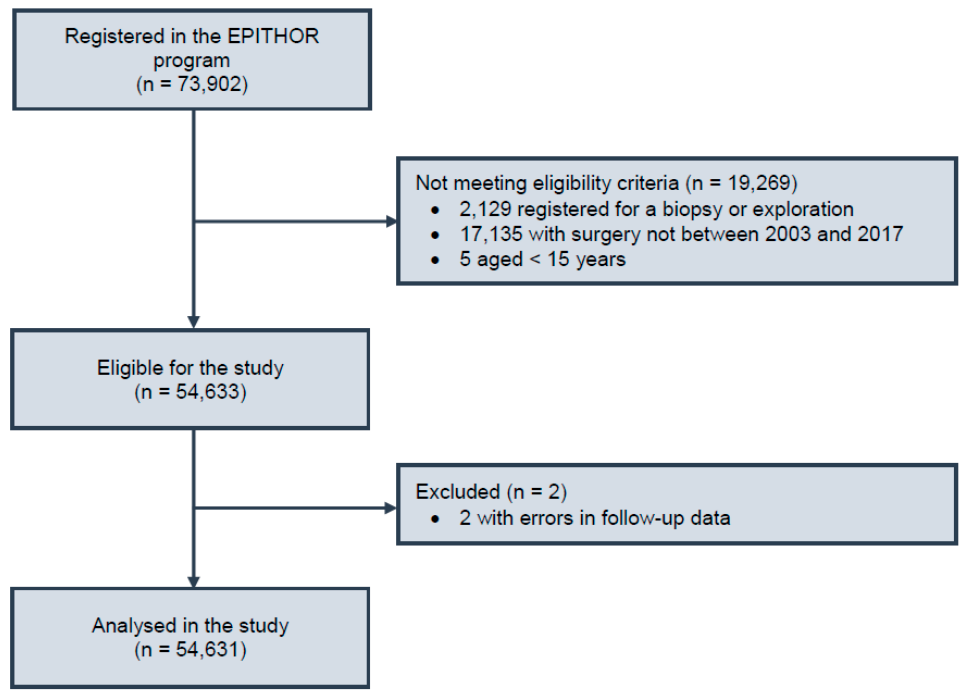
Figure 1. Study flow chart .